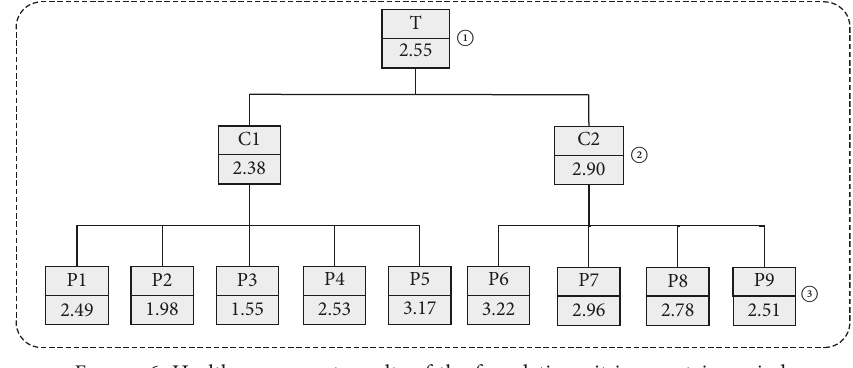
Figure 6: Health assessment results of the foundation pit in a certain